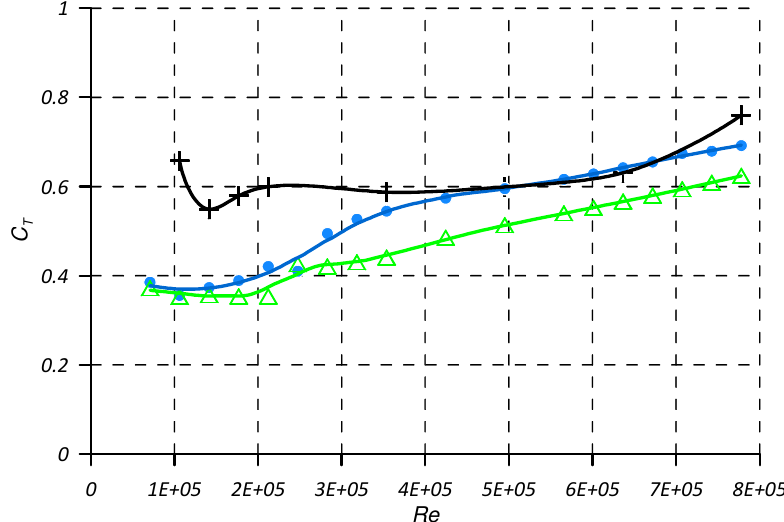
Figure 9. Total resistance coeff. C T : Experiments T = 0.95h (+), CFD T = 0.95h ( • ), CFD T = 0.8h ( (cid:52)